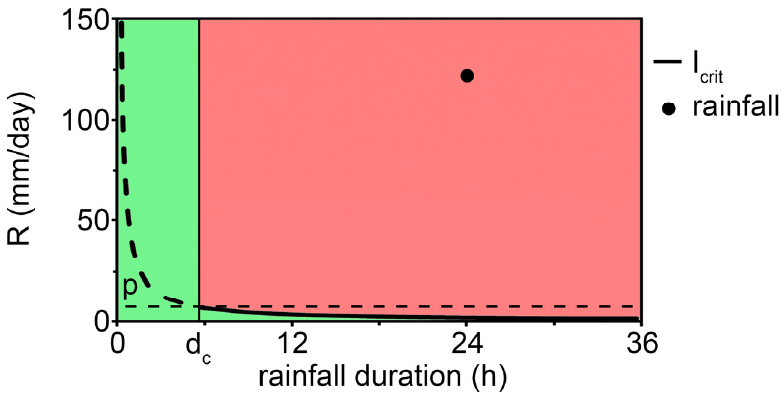
Figure 22. Comparison between the considered rainfall event and the critical curve calculated at the depth of 1.50 m.